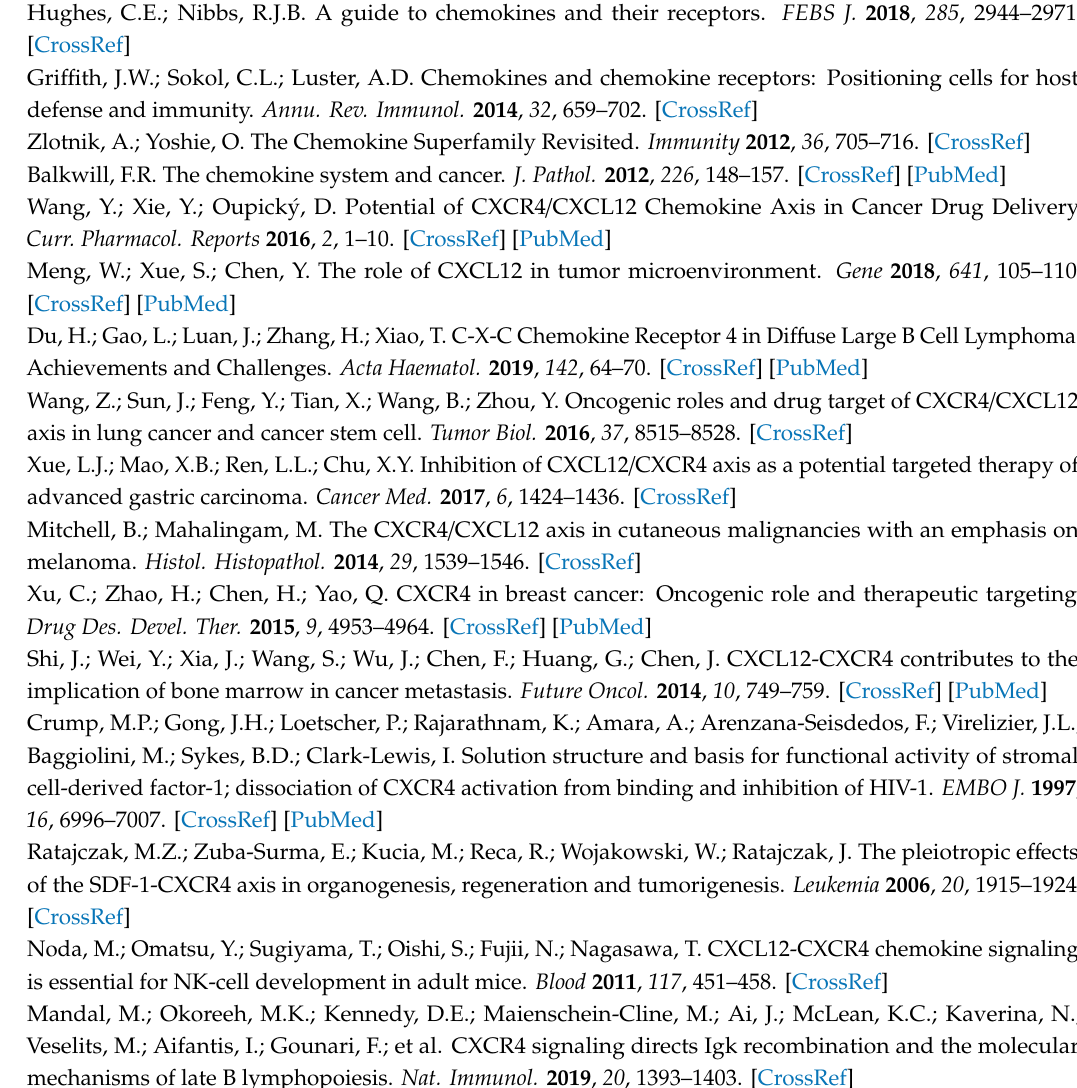
Figure S1: Nanoparticle size and stability, Figure S2: Nanoparticle AF4 analysis, Figure S3: Nanoparticle biotin / streptavidin mediated decoration, Figure S4: Cytokine release induced by NPs and CXCL12-NPs, Figure S5: CXCR4 expression on THP1 cell membrane in di ff erent serum conditioned media, Figure S6: Free CXCL12 pretreatment inhibits CXCL12-NPs internalization, Figure S7: CXCL12-NPs internalization in THP1 cells cultured in 5% Human Serum supplemented medium, Figure S8: Chemotaxis with lower NP concentrations, Figure S9: CXCL12-NPs specifically inhibit CXCR4-mediated THP1 migration and not against di ff erent chemokines / chemokine receptors like CCL5 /